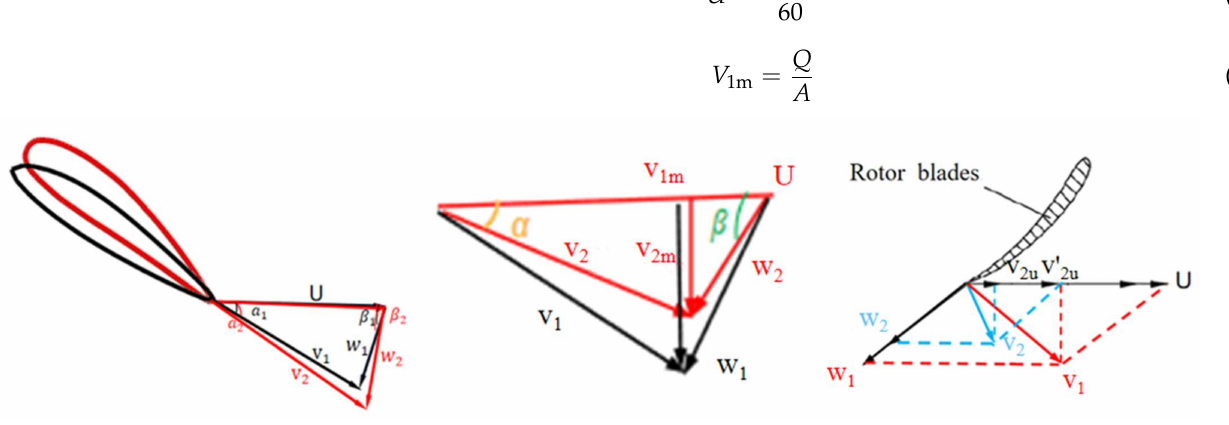
Figure 2. Comparison of the front and rear guide vane airfoil velocity triangles of the modification.